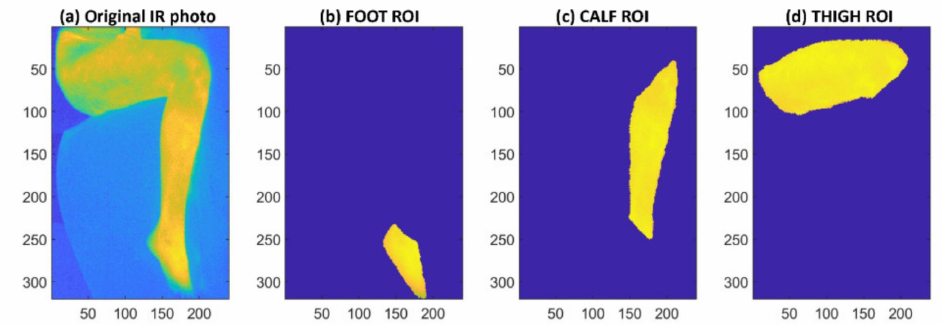
Figure 5. Visualization of MATLAB procedure B: The original thermogram for a random subject ( a ) and the selected ROI for FOOT ( b ), CALF ( c ), and THIGH ( d ). MATLAB Procedure